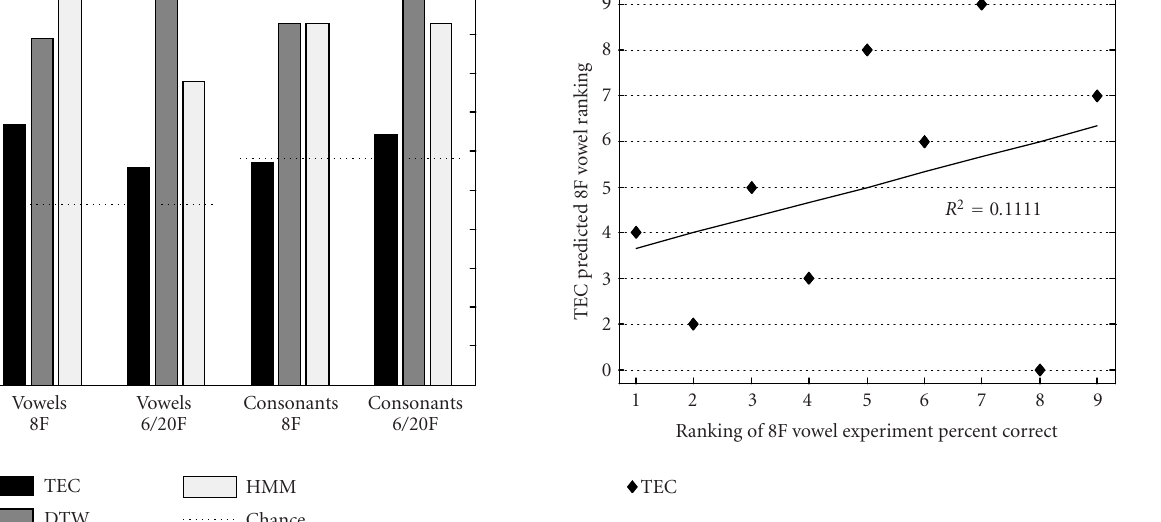
Figure 5: Most frequent incorrect response (MFIR) near predic- tions for each combination of speech material (vowel, consonant) and acoustic model (8F, 6/20F). Chance scores are included for comparison.